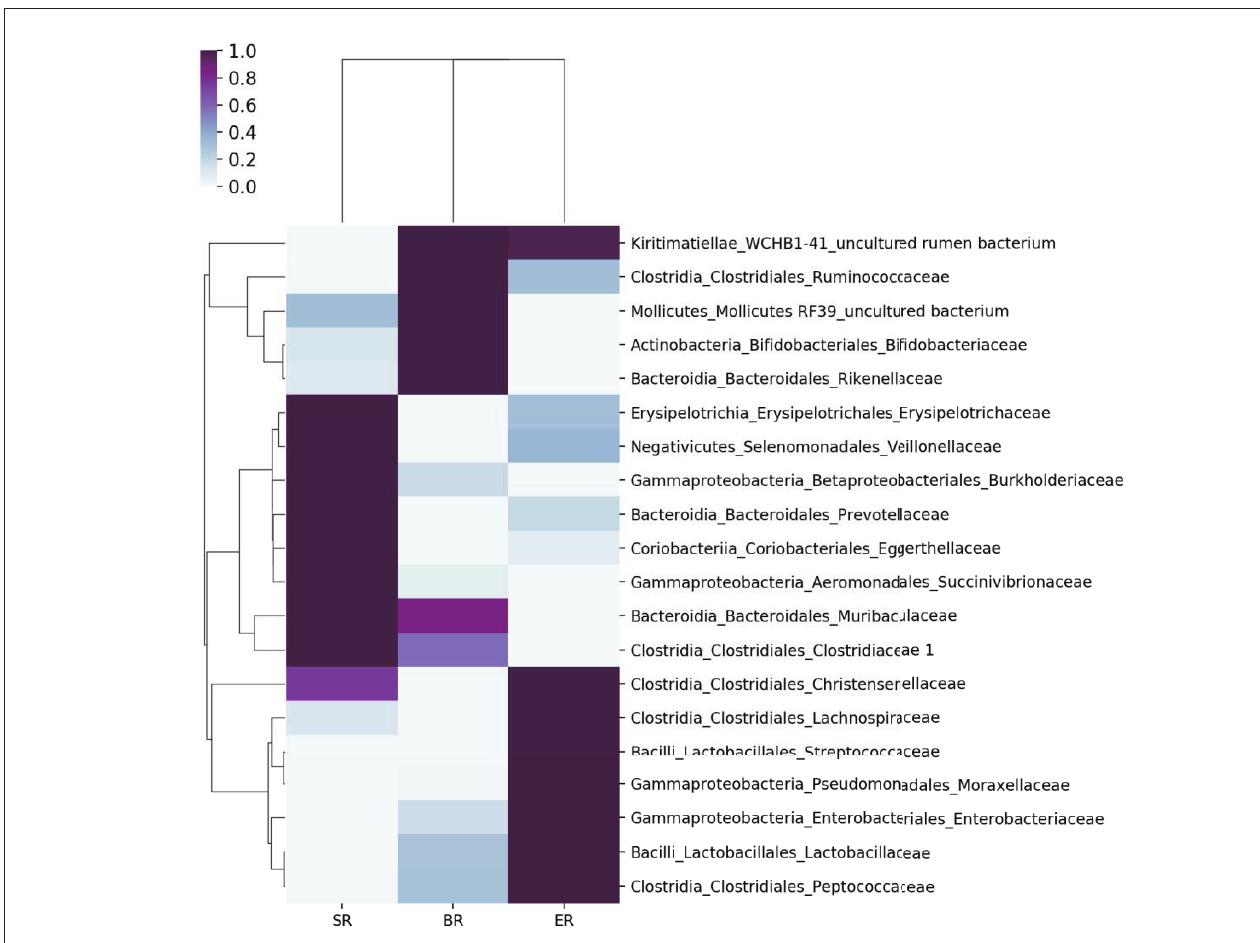
FIGURE 4 | Comparisons of microbial community at the family level in different groups of monkeys. A heatmap was used to visualize the microbial composition in three groups of monkeys by 16S rRNA